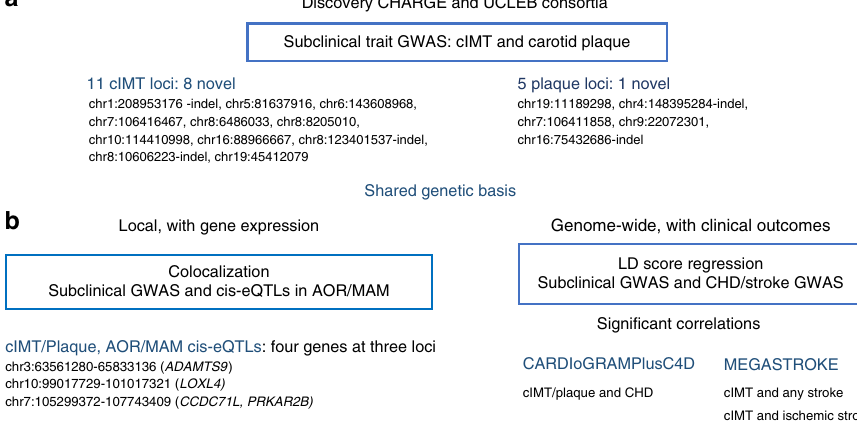
Fig. 1 Overall study design. a GWAS meta-analyses of cIMT and carotid plaque for gene discovery. b Local and genome-wide shared genetic basis using gene expression and clinical outcomes GWAS